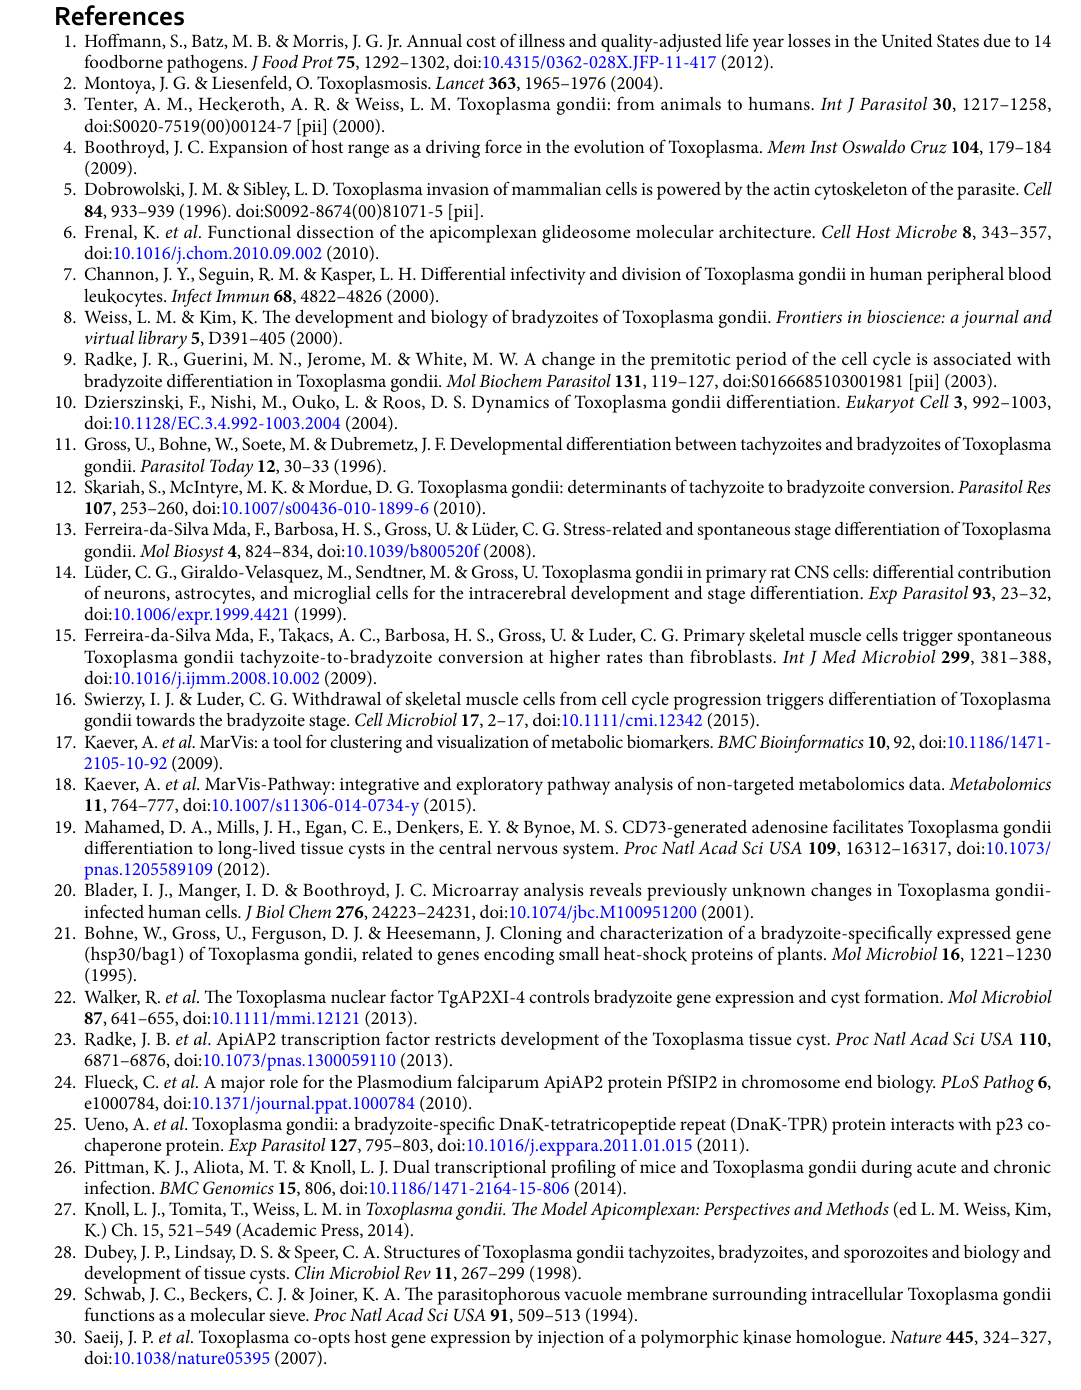
Astrocytes or fibroblasts were incubated with rat anti-glial fibrillary acidic protein (GFAP; Zymed, San Francisco, CA) and mouse anti-actin (clone C4, kindly provided by J. Lessard, Cincinnati, OH) at dilutions of 1:500 and 1:250, respectively. Parasite-specific proteins were simultaneously labelled using rabbit or mouse polyclonal anti- T. gondii antiserum depending on the host cell type-specific primary antibody (both at a dilution of 1:100). After having been washed, host cells were stained using Cy2-conjugated donkey F(ab’) 2 fragment anti-rabbit, anti-mouse or anti-rat IgG. Parasite-bound antibodies were simultaneously labelled using Cy5-conjugated don- key F(ab’) 2 fragment anti-rabbit or anti-mouse IgG (all secondary antibodies from Dianova, Hamburg, Germany). The total cell population was visualized by incubation for 5 min in 5 µ g/ml propidium iodide in PBS. Cells were mounted with Mowiol 4–88 (Calbiochem-Novabiochem, Bad Soden, Germany) and cells were analysed using a Leica TCS SP2 confocal microscope. Data